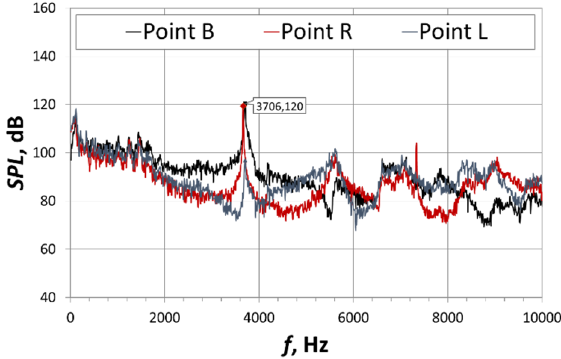
Figure 23. Spectral analysis of SPL for velocity equal to 80 m/s—experimental data.